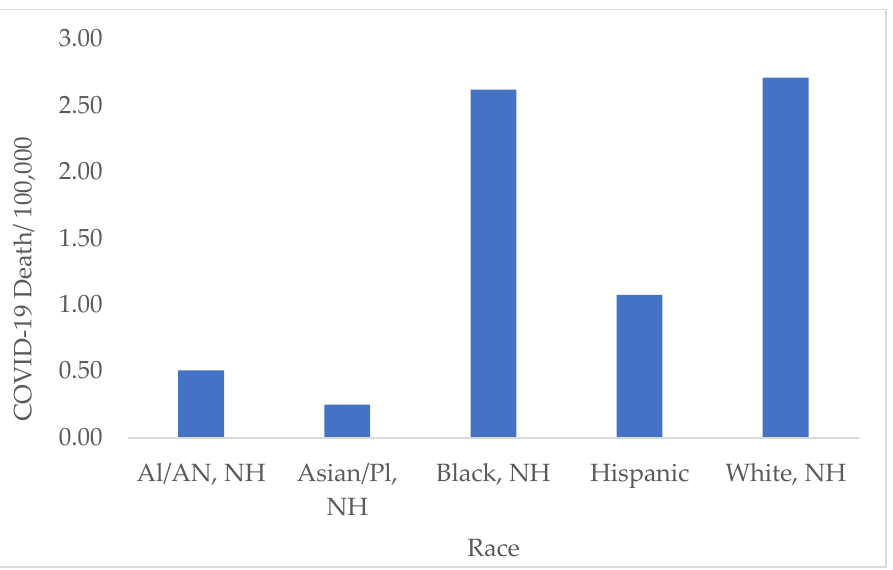
Figure 8. Average number of COVID-19 cases by race in all states from 2020 to 2022. The highest number of COVID-19 cases was observed in the Hispanic population, followed by the Black/African American population ( p < 0.001). Note: AI: American Indian, AN: Alaska Native, NH: Non-His- panic, Pl: Pacific Islander. rates are only shown on the maps.